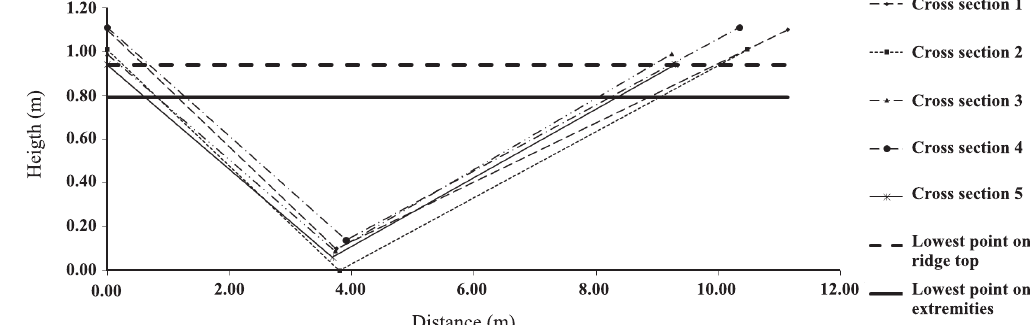
figure 9. Profile of terrace 3 cross section after